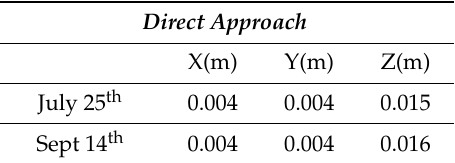
Table 12. Mean standard deviation of five check points from direct approach for the DJI M200 RGB platform from mini bundle